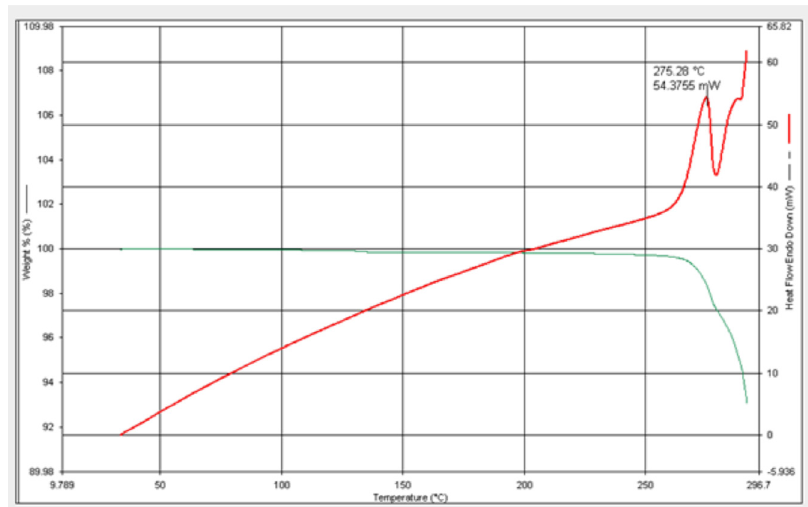
FIGURE 8 (a) - Differential Scanning calorimetric analysis of pure drug